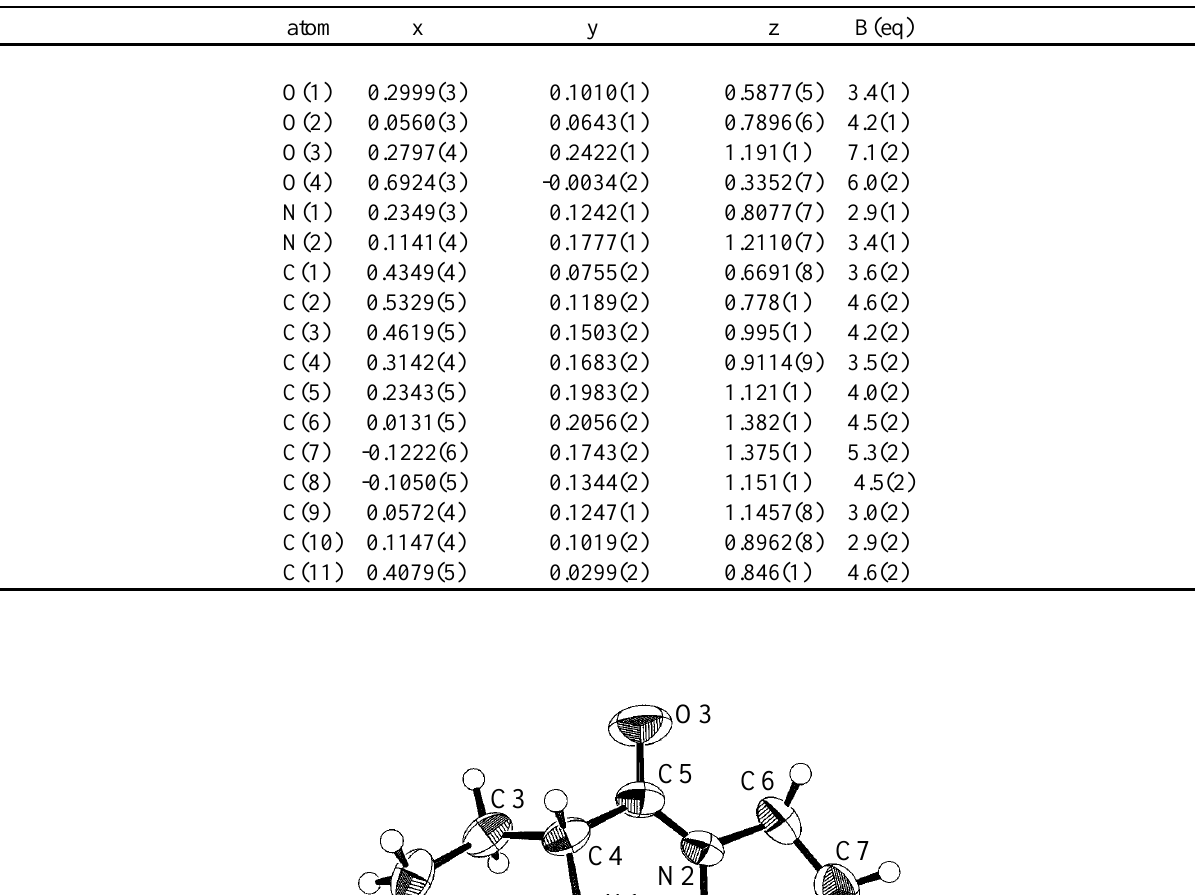
Table 2. Positional parameters and B(eq) for non hydrogen atoms for 8 . Estimated standard deviations in the least significant figure in parentheses .